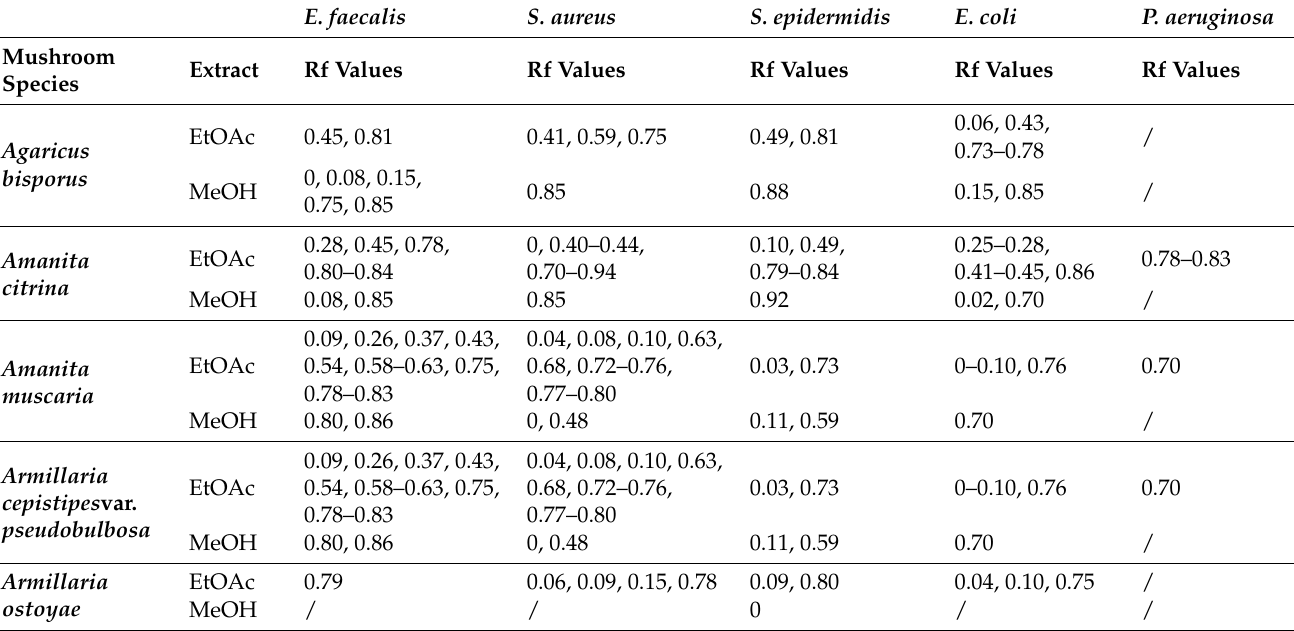
Table A3. Antibacterial activity induced by Agaricales mushrooms against wild-type bacteria ex- pressed as Rf values of inhibition